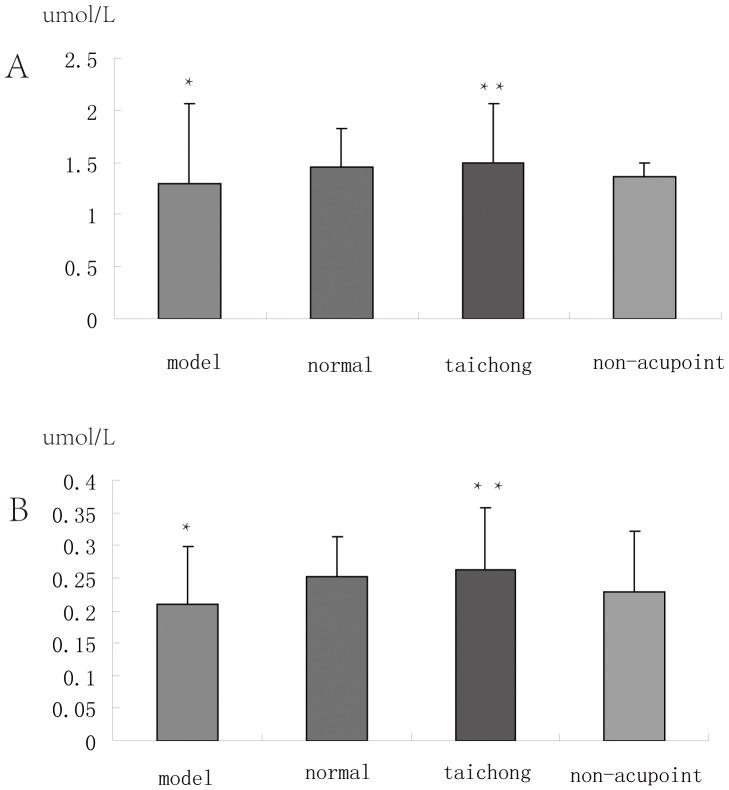
Content of glutathione S-transferase M5 and aldehyde dehydrogenase 2 in rat medulla by ELISA.